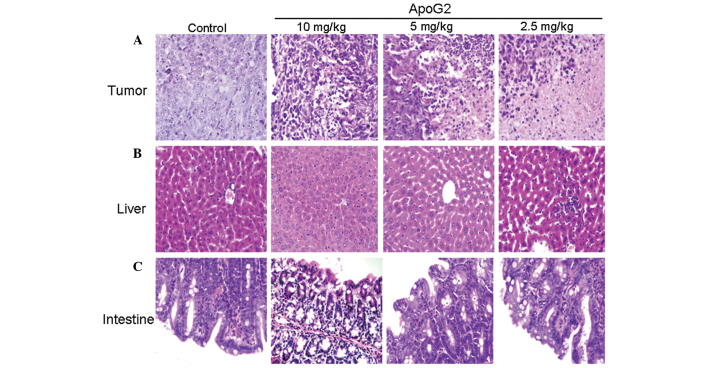
Effects of ApoG2 on the pathological features of transplanted tumors, liver and intestine. (A) Transplanted tumors (H&E; magnification, ×400). (B) Liver (H&E; magnification, ×400). (C) Intestine (H&E; magnification, ×400). H&E, hematoxylin and eosin; ApoG2, apogossypolone.